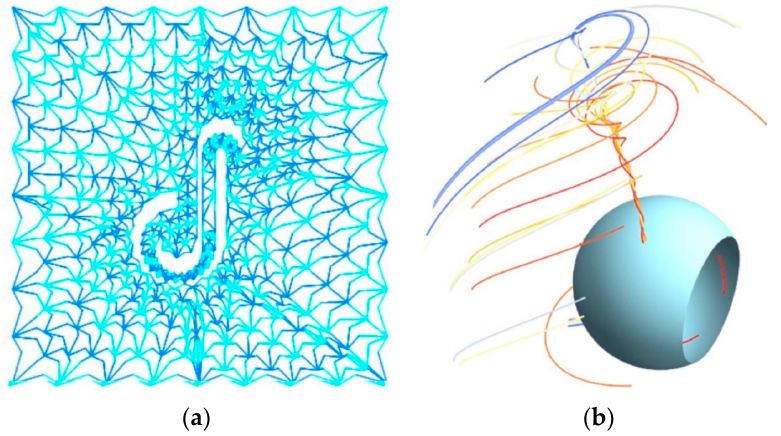
Figure 4. Defining a vertex algebra on a torus helps us to visualize otherwise abstract structures. Starting from a vertex operator algebra (a very small portion is illustrated in ( a )) we made use of the attractors and the corresponding ordinary differential equations described by [38]. In ( b ), the j -function on the attractor torus displays one coordinate initialized with a j -function value.